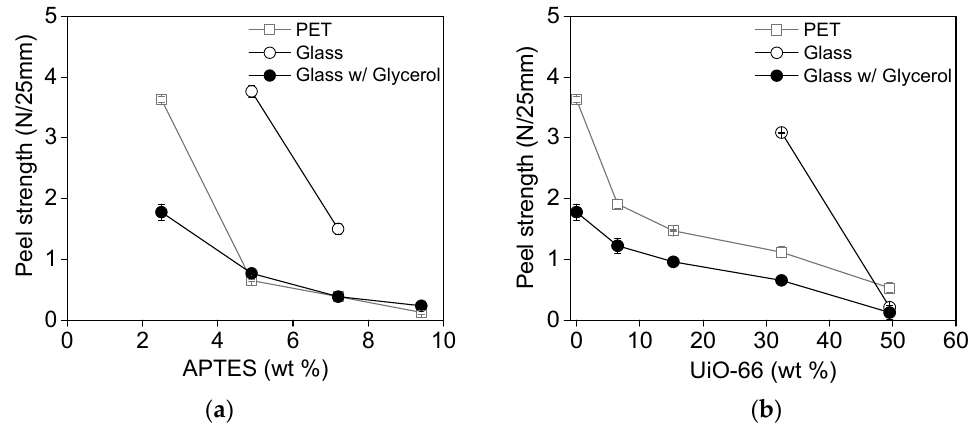
Figure 8. Cross-section SEM images of the UiO-66/DSPD composite films with ( a ) 0, ( b ) 6.5, ( c ) 15.3, ( d ) 32.4, and ( e ) 49.5 wt.% UiO-66 contents on polyethylene (PET) substrates.